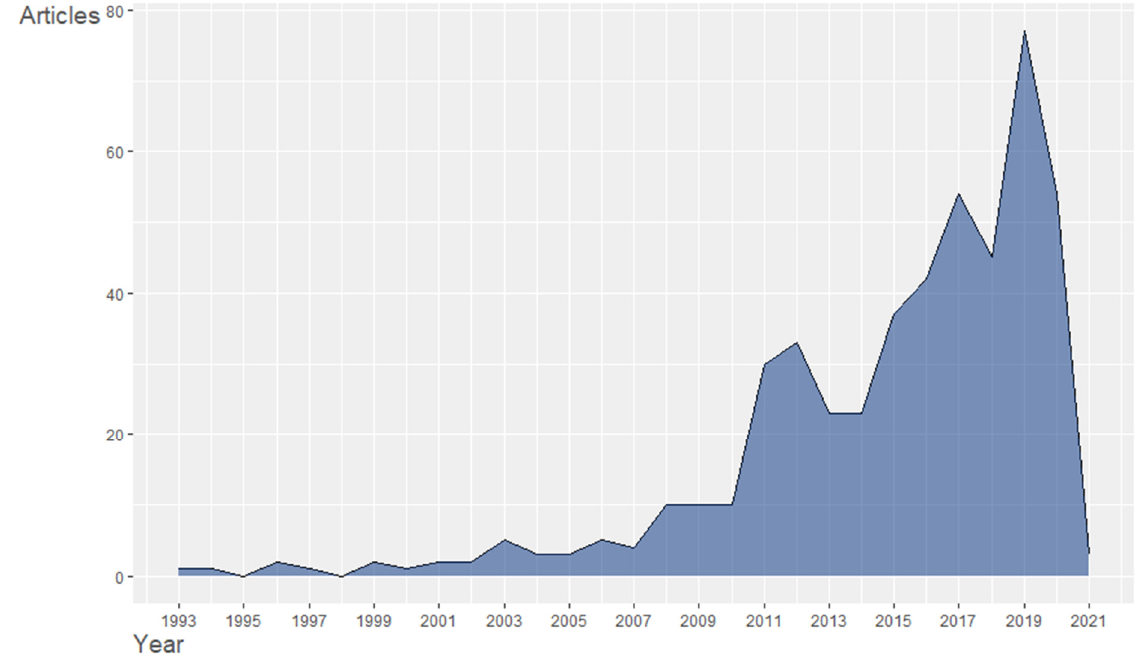
Figure 2. MCDA documents related to civil engineering—publication rates (per annum) over time.